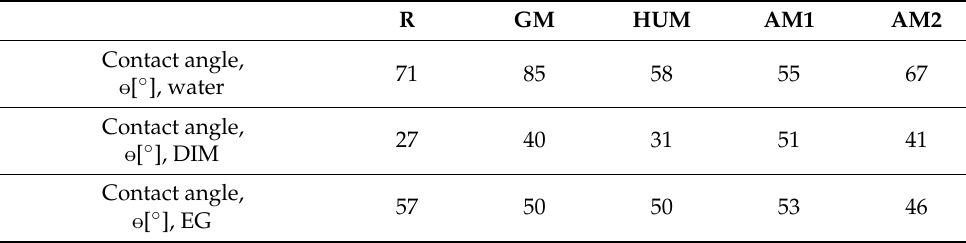
Table 2. Contact angle values for experimental bone cement samples. R